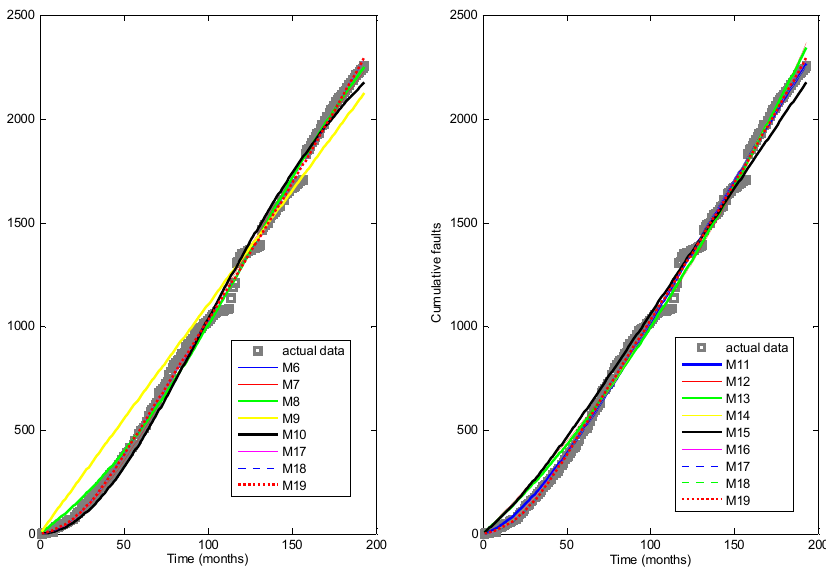
Figure 6. Comparisons of the fitting results for M1-M5 and M17-M19 based on DS-3. Table 6. Parameter estimates of M6 to M19 for DS-3. Parameter Estimation Values Models